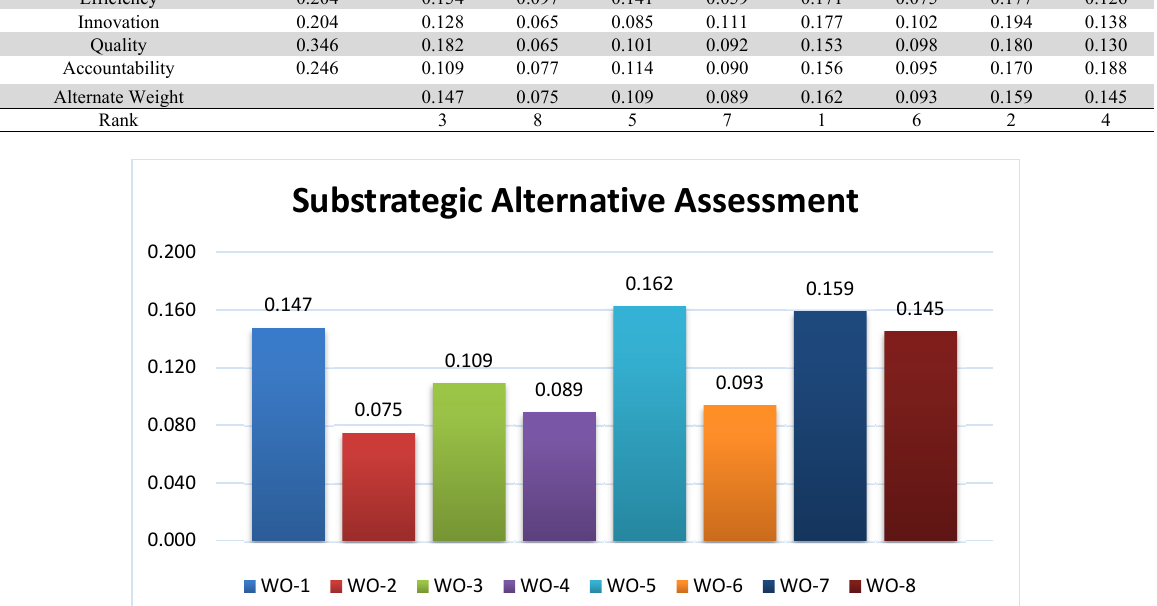
Fig. 6. Assessment of the TNI’s RMA development strategy towards a competitive advantage in the South China